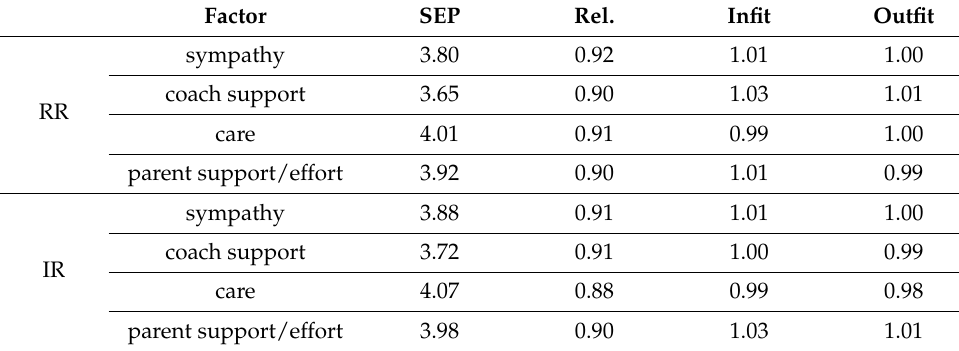
Table 11. Response and item reliability.